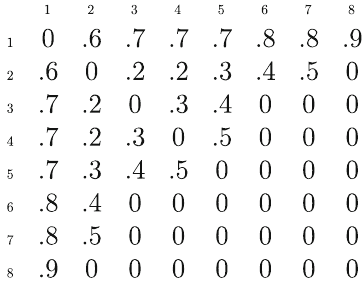
Fig. 2 Adjacency matrix of a dominant NSG